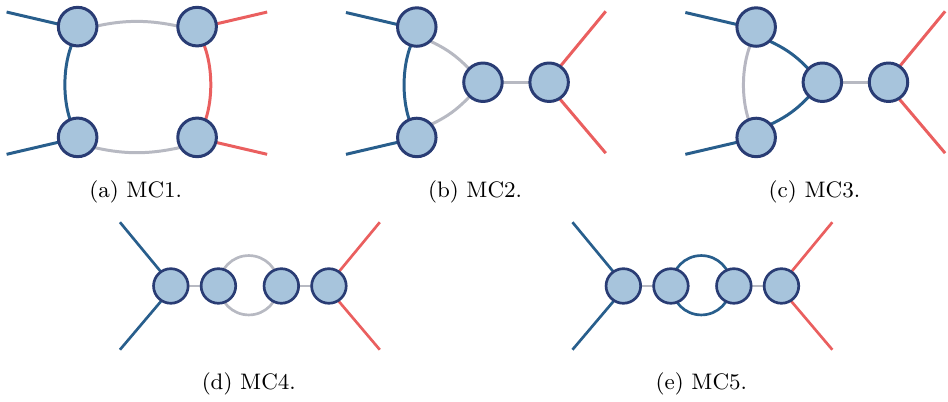
Figure 1 . All distinct maximal cuts of the one-loop four-point amplitude, not including tadpole graphs. Blue blobs represent three point amplitudes, and exposed legs represent on-shell propa-